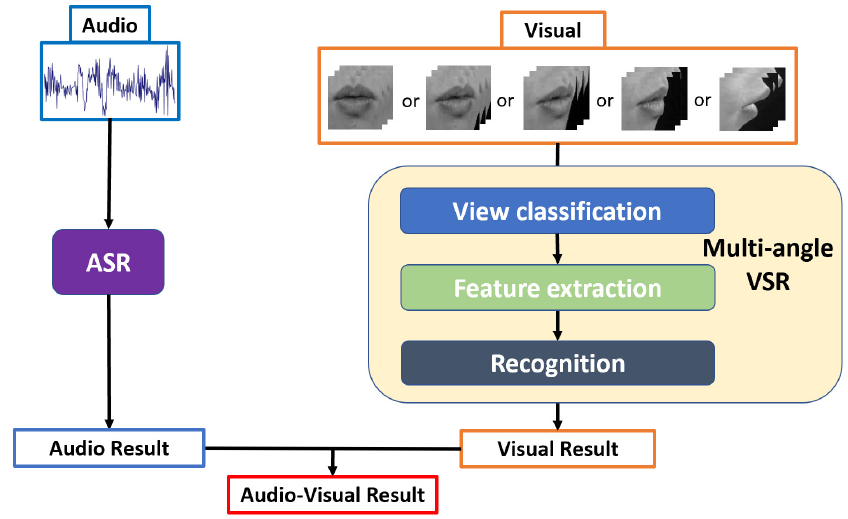
Figure 1. An architecture of our proposed multi-angle AVSR method.